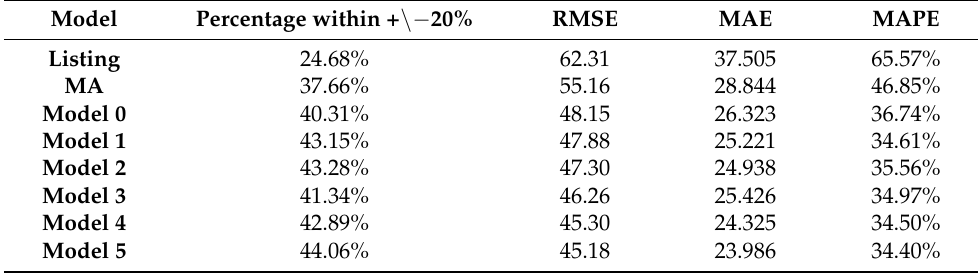
Table 4. SH − 1 Accuracy & Error Metrics Comparison of Models.